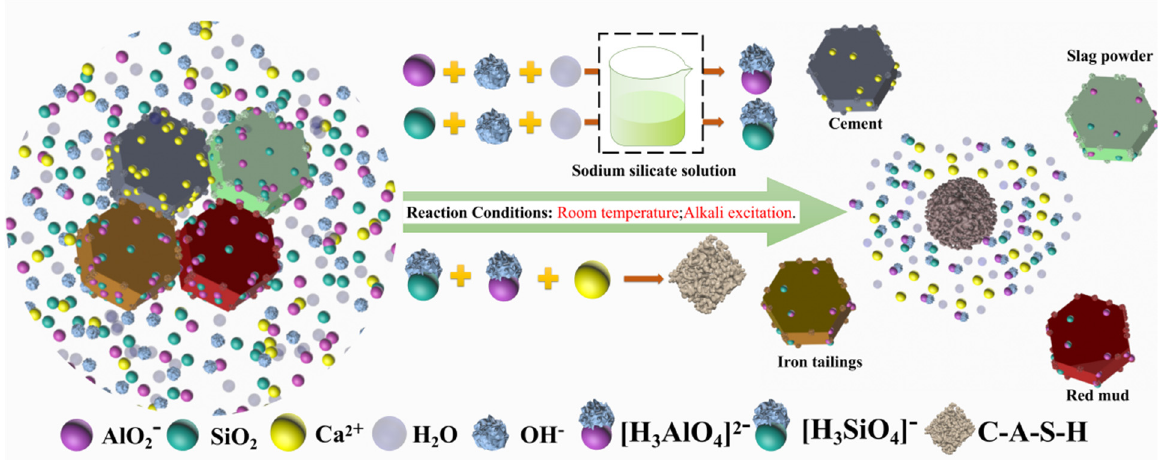
Figure 7. Schematic diagram of the formation of C-A-S-H gels in the AACM.